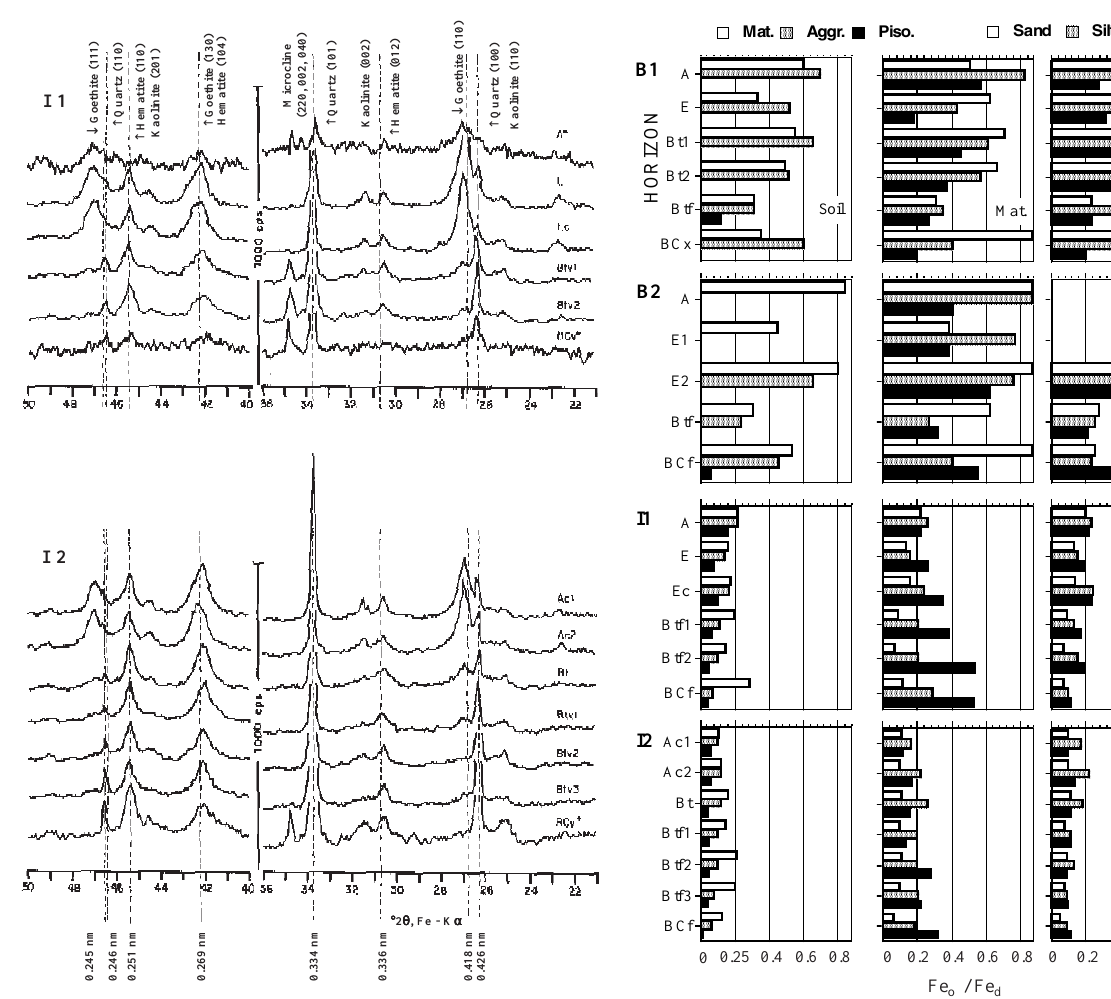
Figure 3. Partial powder X-ray diffractograms of the pisoliths in the > 2 mm phase. Patterns of horizons marked with ‘*’ have cps scale expanded 2x.